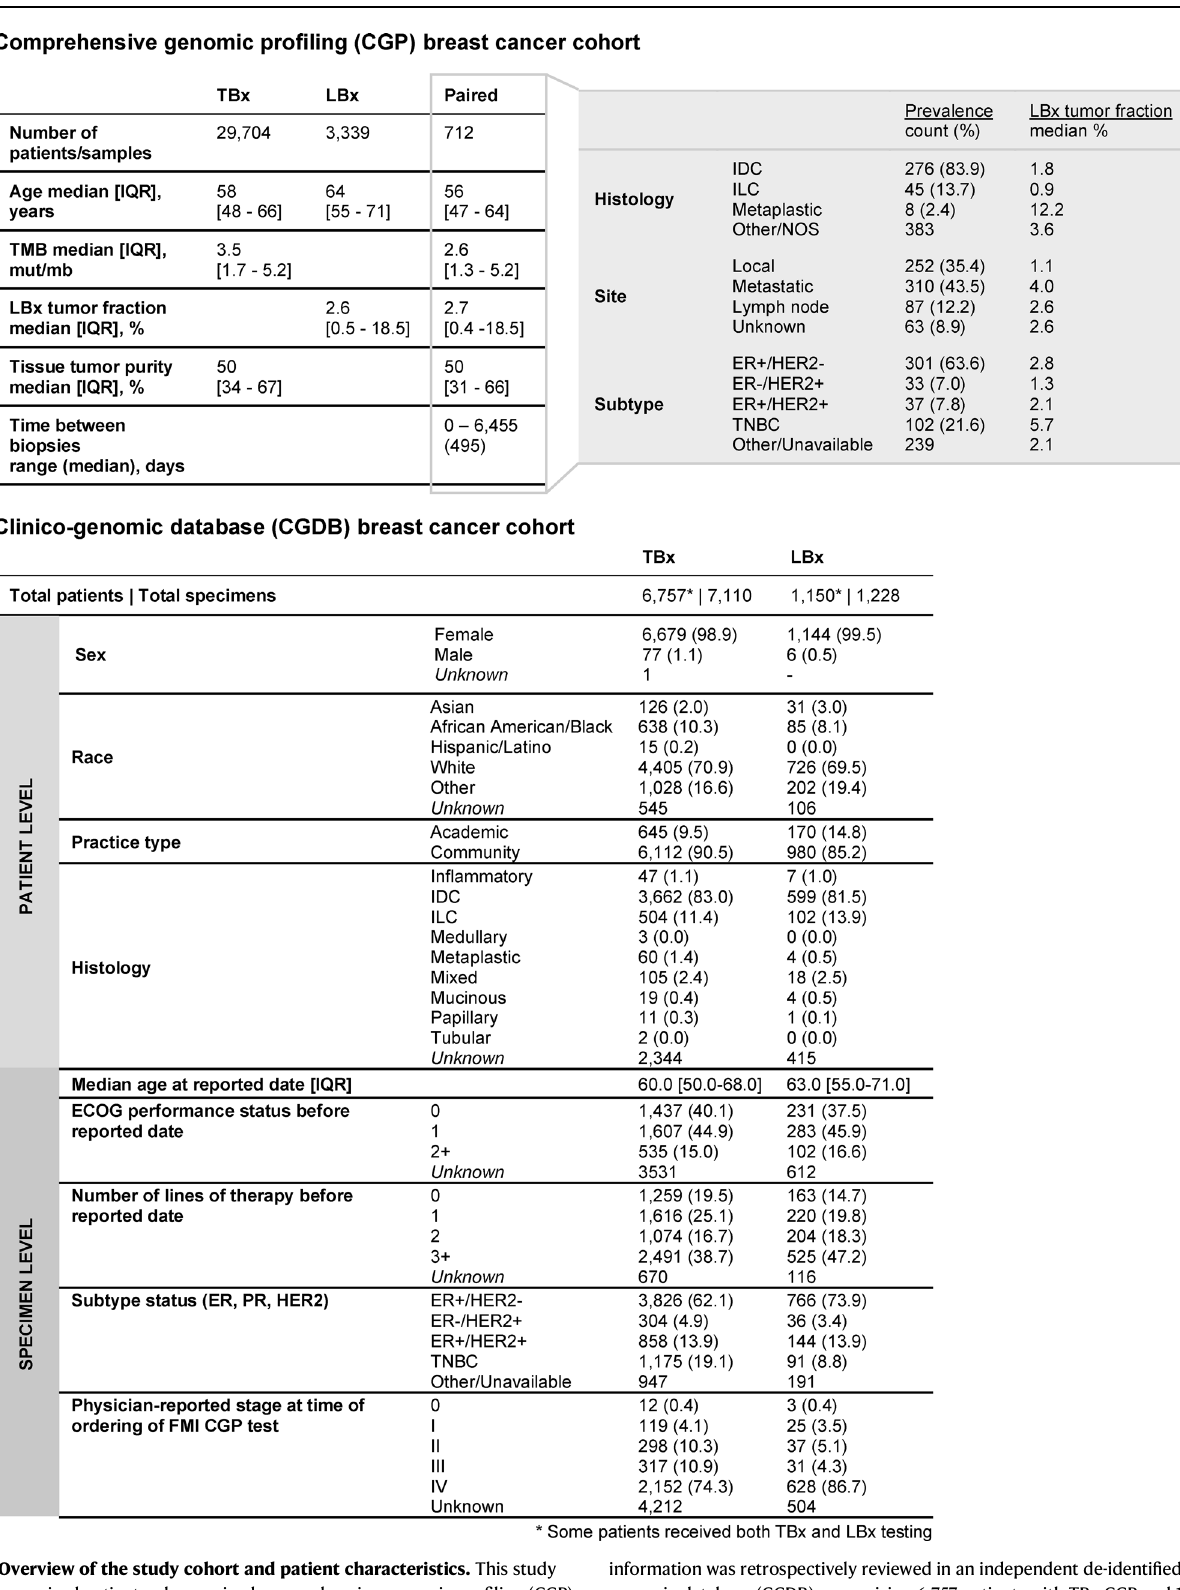
information was retrospectively reviewed in an independent de-identi fi ed clinico- genomic database (CGDB), comprising 6,757 patients with TBx CGP and 1150 patients with LBx CGP (bottom). Patient and specimen-level characteristics have been provided for each of these cohorts. Additional information such as ECOG status, lines of therapy are available for samples in the CGDB cohort. (ILC invasive lobular carcinoma, IDC invasive ductal carcinoma, TNBC triple-negative breast cancer, NOS not otherwise speci fi ed, IQR interquartile range).